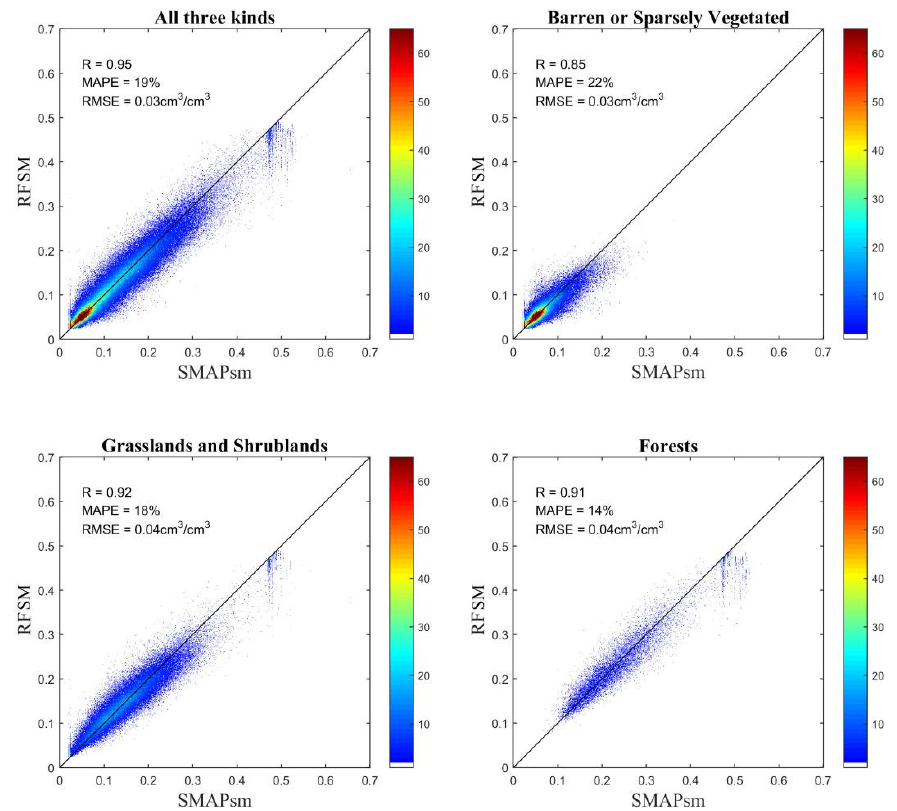
Figure 4. Density scatterplots for RFSM ( y -axis) vs. soil moisture active passive (SMAP) soil moisture (SM) ( x -axis) over the test period (May 2017 to May 2018).